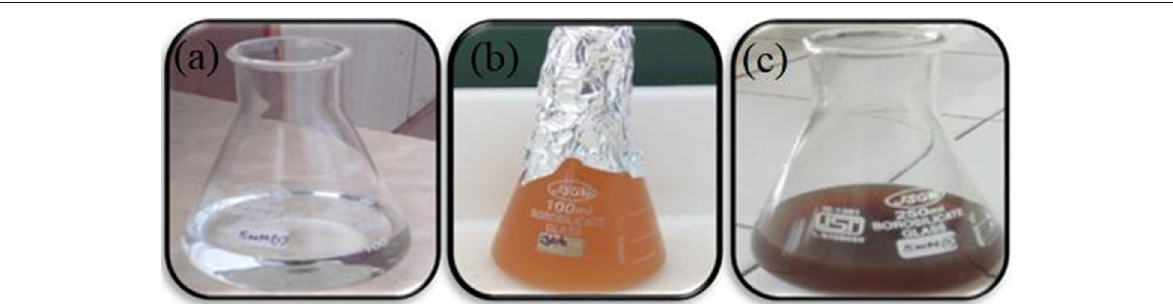
Fig. 2 CuO NPs synthesis visual observation ( a ) copper sulphate solution ( b ) initial colour transition ( c ) final colour transition